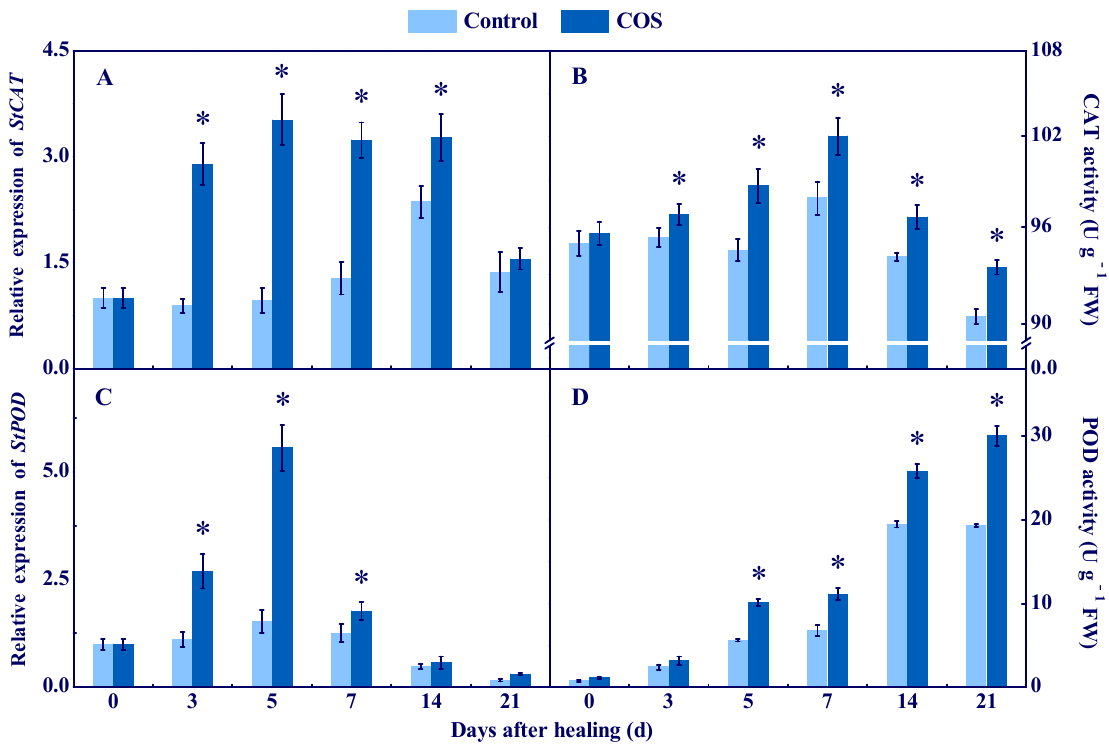
Figure 3. Effect of COS treatment on the relative expression of StCAT ( A ) and StPOD ( C ), and the activities of CAT ( B ) and POD ( D ) at wounds of potato tubers during healing. Bars indicate standard error. Asterisks denote significant differences ( p < 0.05).